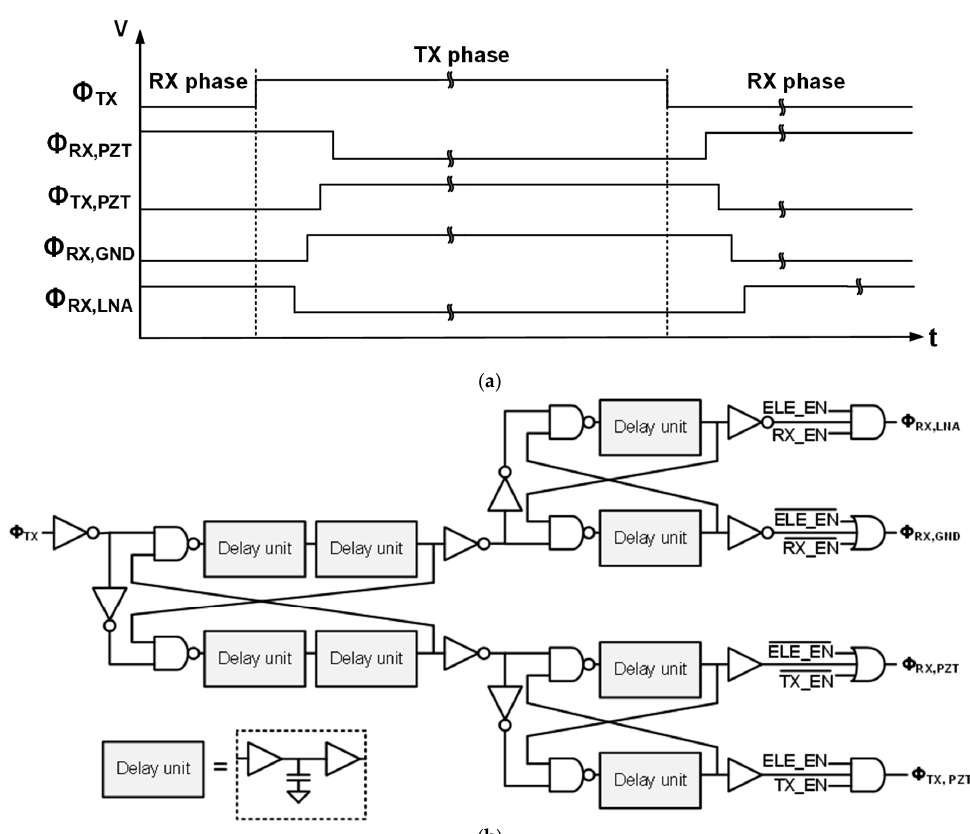
Figure 6. ( a ) The proposed timing diagram of the control signals to minimize the switching transients and ( b ) implementation of the switch controller to generate such signals.